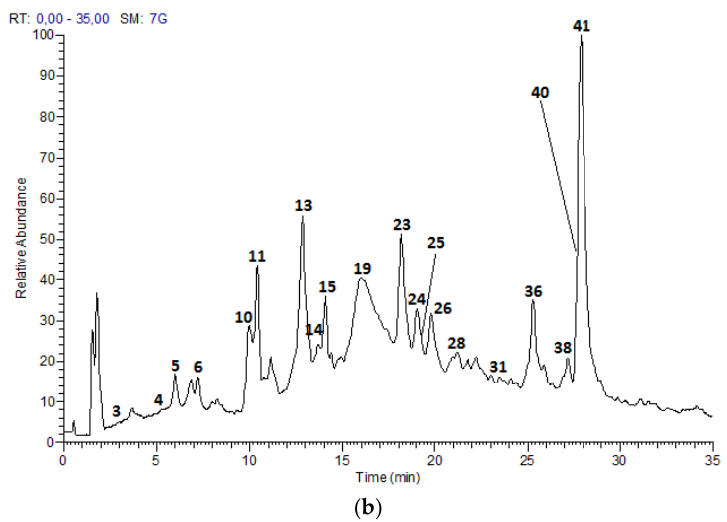
Figure 2. HPLC Chromatograms of P. domestica extracts: ( a ) Satsuma skin ( b ) Satsuma flesh in a Hypersil Gold AQ RP-C18 column (200 mm × 2.1 mm × 1.9 µm) using a LTQ Orbitrap XL Mass spectrometer (Thermo Scientific™, Walthman, MA, USA) in a mass range from 100 to 2000 amu.